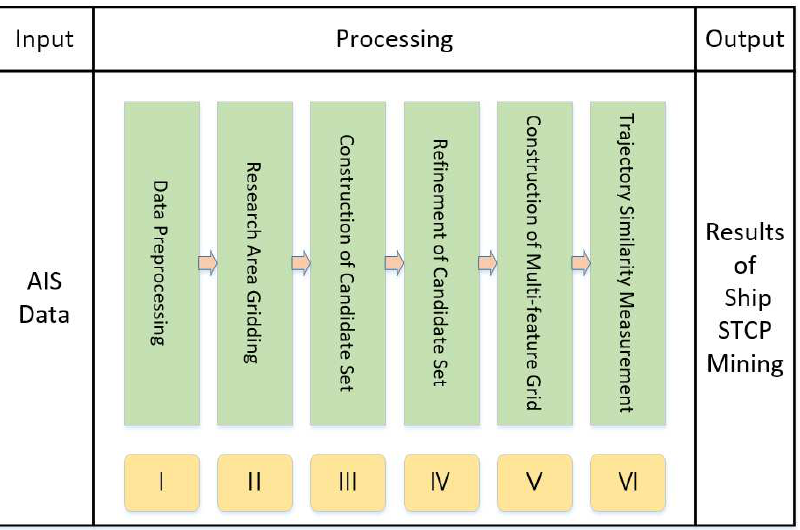
Figure 1. The framework of the entire processing.